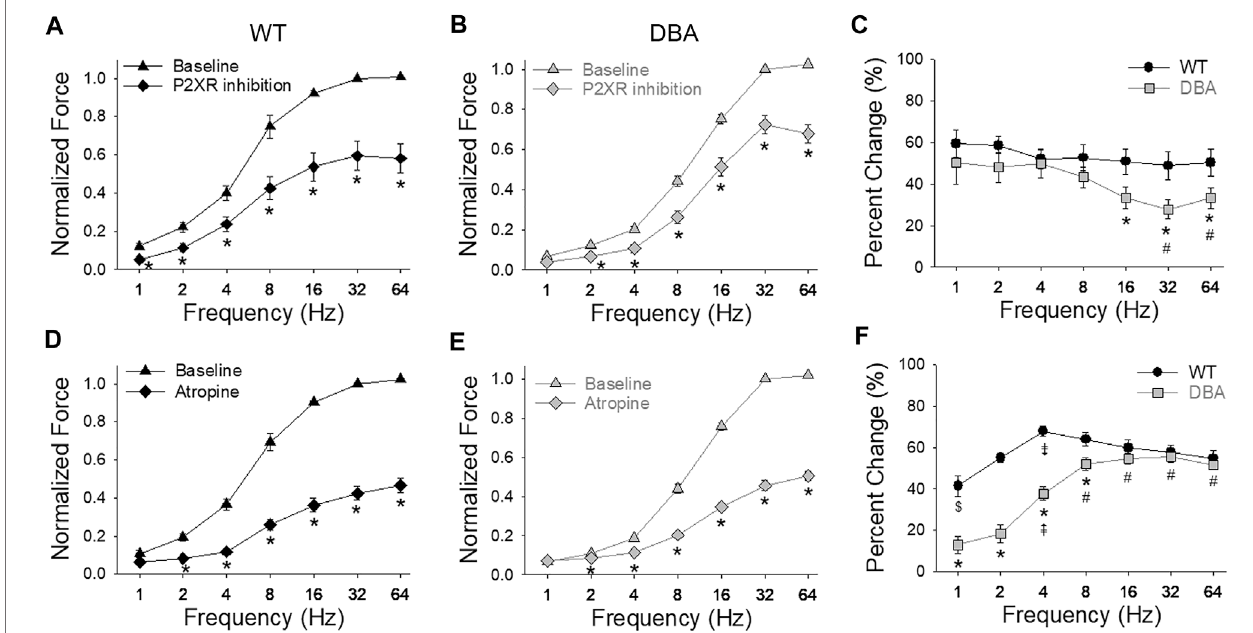
FIGURE 9 | Purinergic and cholinergic inhibition of neurally evoked contractile responses. Effect of post-junctional inhibition on the frequency-response curves in WT [ (A,D) , black symbols] and DBA [ (B,E) , gray symbols] detrusors. Contractile responses to EFS in the absence (triangles) versus the presence (diamonds) of P2XR antagonists (NF449 and 5BDBD) in detrusors from (A) WT and (B) DBA mice. Following purinergic inhibition, responses to EFS of both WT and DBA detrusors were signi fi cantly reduced at all frequencies as indicated by asterisks. Data are normalized by the baseline response (without inhibitors) at 32 Hz. (C) Compared to WT (black circles), the reduction in force relative to the baseline response due to purinergic inhibition (change from baseline) was signi fi cantly lower in DBA detrusors (gray squares) at frequencies of stimulation above 8 Hz (*signi fi cantly lower than WT at this frequency; # signi fi cantly lower than 2 and 4 Hz within DBA). Comparison of the effect of muscarinic receptor antagonist atropine on nerve-mediated contractile responses in (D) WT and (E) DBA detrusors. Normalized force is graphed versus stimulation frequency, in the absence (triangles) and presence (diamonds) of atropine. Data are normalized by baseline responses at 32 Hz. Atropine signi fi cantly reduced the responses of both WT and DBA detrusor to EFS at frequencies greater than 1 Hz (*). (F) The inhibitory effect of atropine on nerve mediated responses relativeto baseline conditions was signi fi cantly less in DBA (gray squares) at stimulations from 1to 8 Hz compared tothe effectin WT (black circles). (* signi fi cantly lower thanWTatthisfrequency;#signi fi cantlyhigherthan1 – 4 HzwithinDBA; ⇞ signi fi cantlyhigherthan1and2 HzwithinDBA; ⇟ signi fi cantlydifferentthan1,2,32and64 Hz within WT; $ signi fi cantly lower than 8 – 32 Hz within WT (N = 11 WT, N = 13 DBA, symbols indicate p < 0.05)).